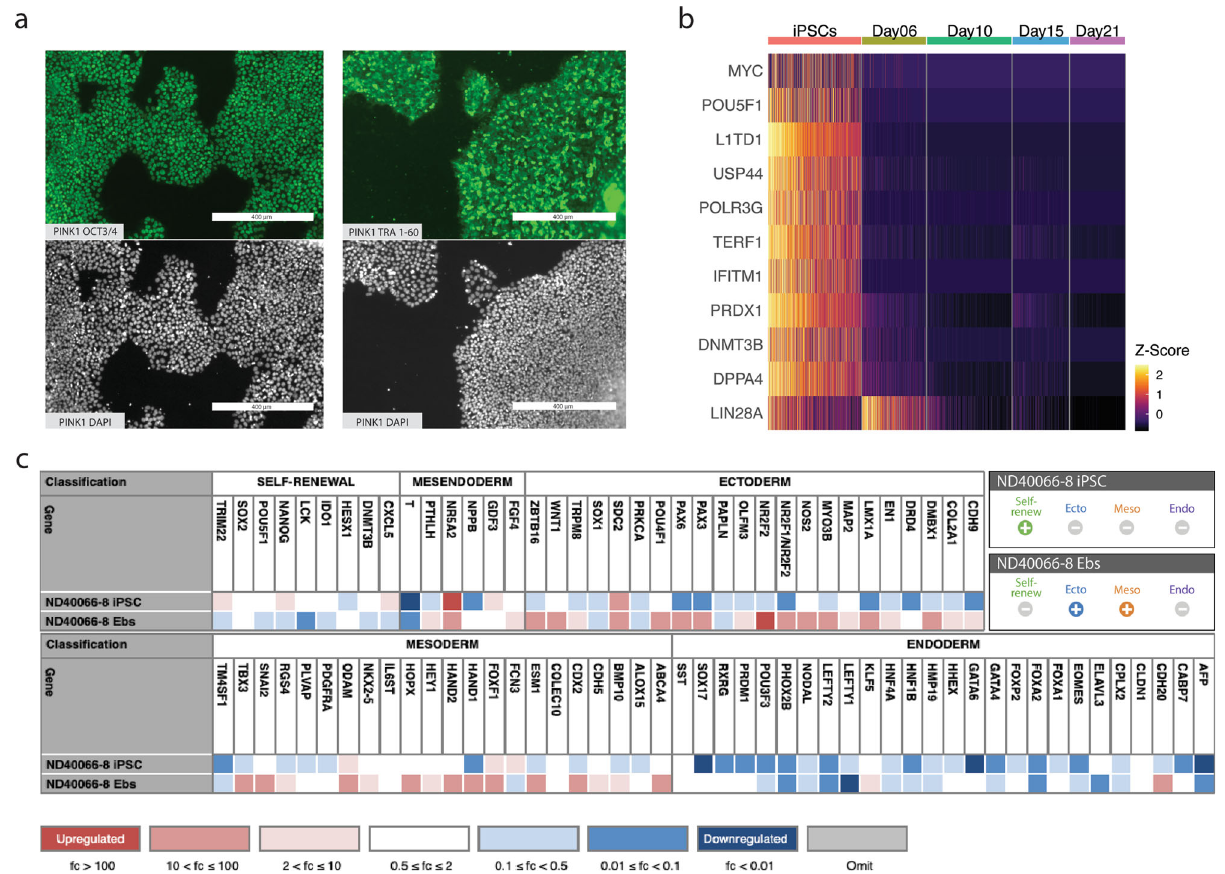
Fig. 2 Classi fi cation of iPSC status. a Immunocytochemistry (ICC). Staining for the iPSC markers POU5F1 (more commonly known as OCT3/4) and TRA- 1-60 of iPSC colonies, prior to differentiation. DAPI was used to stain cell nuclei as a reference. b Expression of genes known to indicate iPSC status ( MYC and POU5F1 ) and of genes identi fi ed by a differential expression analysis between iPSCs and differentiating cells (also see Supplementary Fig. 12). Colors correlate to normalized counts ( z -score, centered, and scaled) of the indicated genes. TDGF-1 is expressed in iPS cells of high stemness; 41 L1TD1 , USP44 , POLR3G, and TERF1 are essential for the maintenance of pluripotency in human stem cells; 47 – 50 IFITM1 , PRDX1 , DNMT3B , DPPA4 , and LIN28A and are associated with stemness 51 – 53,137,138 . c Results of Scorecard analysis of iPSCs and embryonic bodies (EBs) 44,45 . iPSCs are expected to show high expression of self-renewal genes and low expression of mesoderm, ectoderm, and endoderm markers. EBs are cells at an early stage of spontaneous differentiation. Scorecard analysis of EBs determines the iPSC line ’ s potential to differentiate into the three germ layers, hence, EBs are expected to express few or no self-renewal genes and to show expression of some mesoderm, ectoderm and endoderm markers: Ecto±, Meso±,